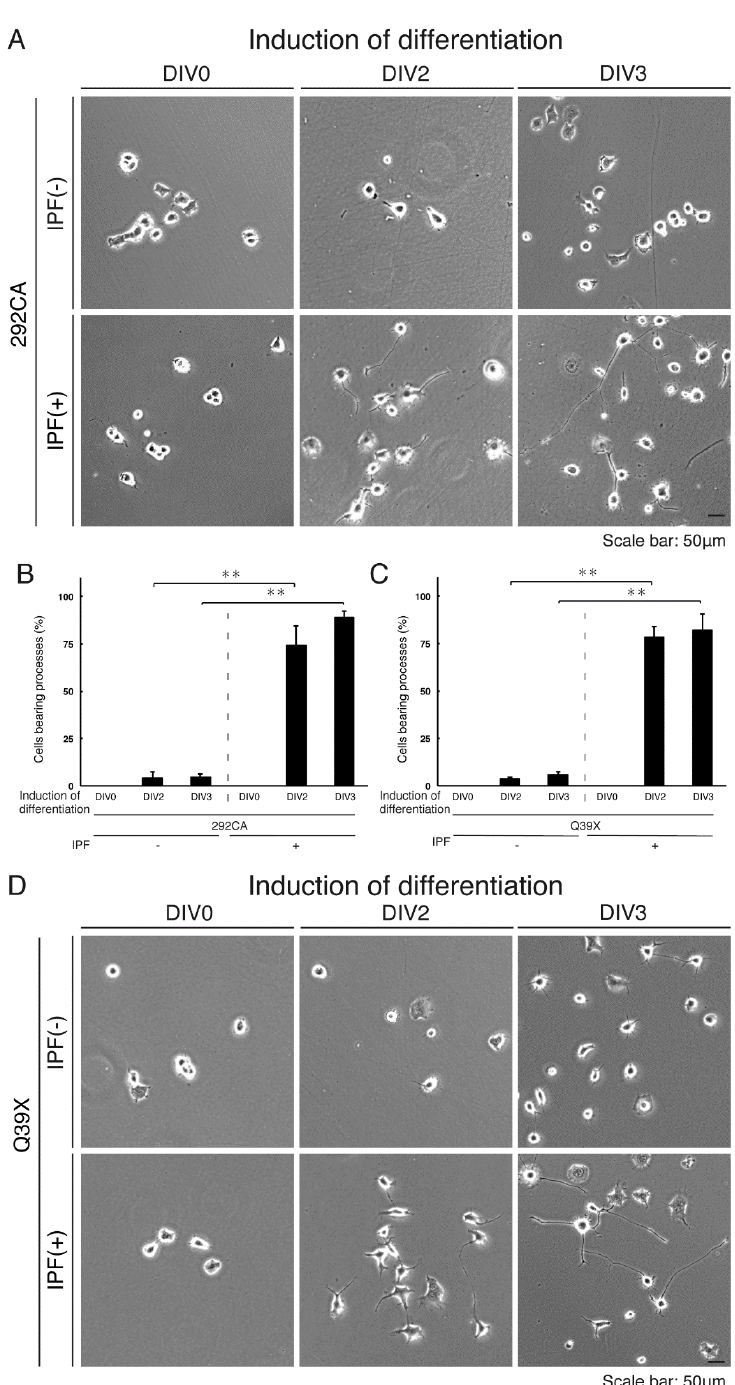
Figure 12. Treatment with ibuprofen reverses phenotypes of cells harboring each of the AIMP1 mutant constructs. ( A , B ) We allowed N1E-115 cells stably harboring the 292CA mutant constructs to di ff erentiate for 0, 2, or 3 days (DIV0, DIV2, or DIV3) in the presence or absence (vehicle control) of ibuprofen (IPF, 100 µ M). Percentages of di ff erentiated cells bearing neurite-like processes that were at least one cell body in length are statistically shown (**, p < 0.01; n = 3 fields [total 240 cells]). The bar indicates 50 µ m. ( C , D ) We allowed N1E-115 cells stably harboring the Q39X mutant constructs to di ff erentiate for 0, 2, or 3 days (DIV0, DIV2, or DIV3). Percentages of di ff erentiated cells bearing neurite-like processes that were at least one cell body in length are statistically shown (**, p < 0.01; n = 3 fields [total 240 cells]). The bar indicates 50 µ